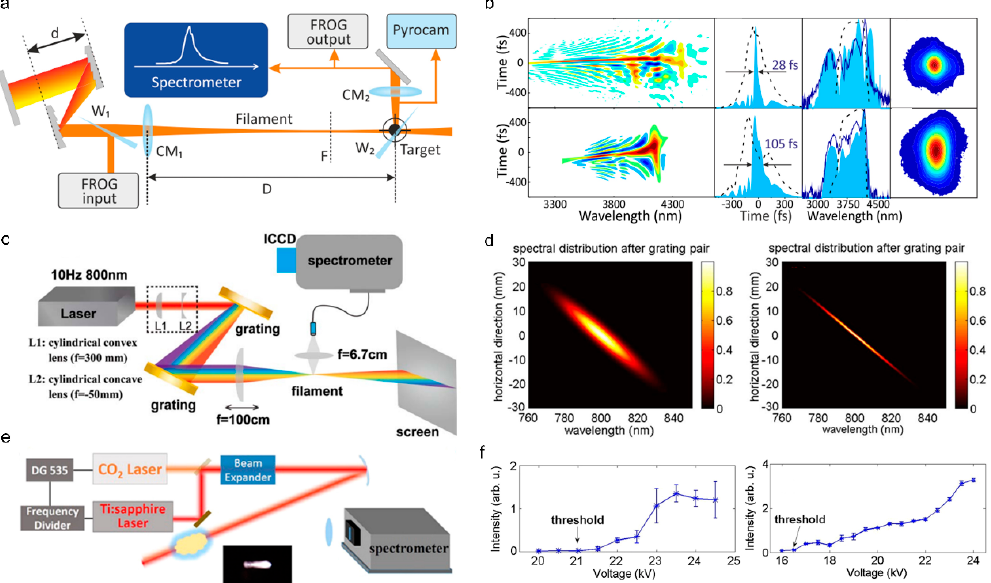
Figure 10. ( a ) Experimental setup for controlling the chirp to generate filament: CM 1 , curved mirror, assisting filamentation, f = 7 m; CM 2 , reimaging curved mirror; W 1,2 , attenuating CaF 2 -wedges; D, the distance between CM 1 and the position of a “Target”; F, the position of the linear focus. ( b ) The compressed temporal pulse inside the filament [167]. ( c , d ) Experimental setup for improving the peak intensity of filament by spatiotemporally manipulating and the reshaped spatiotemporal distribution [174]. ICCD, intensified charge coupled device. ( e ) Experimental setup for enhancing the plasma density assisted by a nanosecond laser. DG 535: digital delay generator. ( f ) Compression of signal intensity using a single CO 2 laser (left) and the dual laser beam (right) [180].